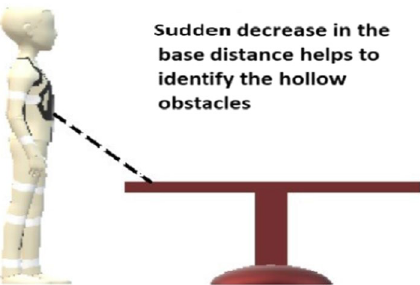
Fig. 9 Detection of table with hollow base